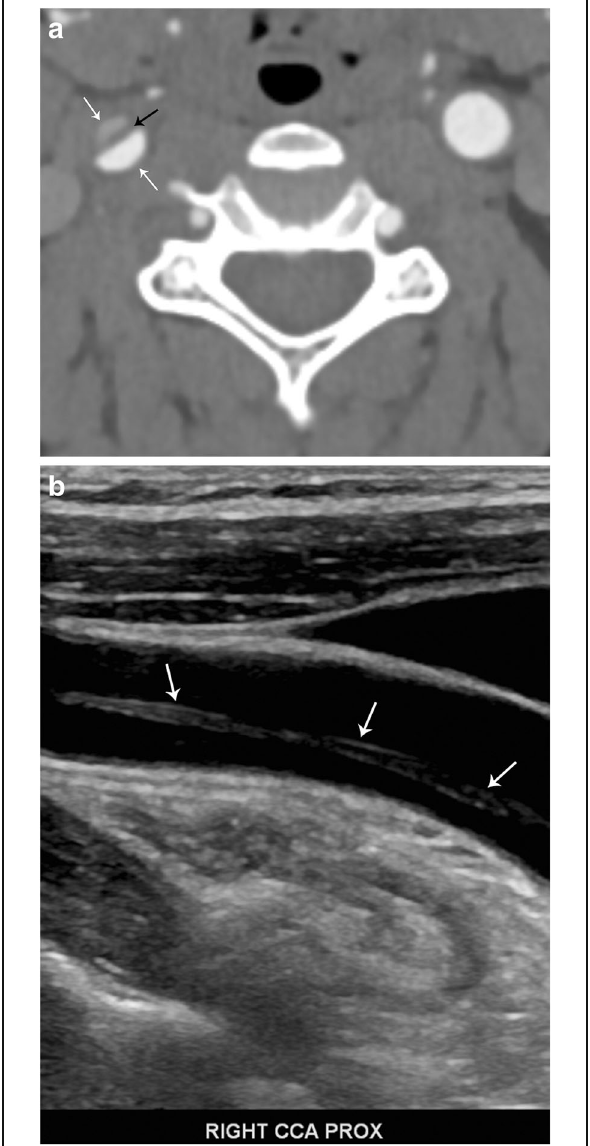
Fig. 12 Carotid arterial dissection. a Axial contrast-enhanced CT image demonstrates an intimal flap (black arrow) and "double lumen" sign (white arrows) in the right common carotid artery. b Sagittal grayscale ultrasound image confirms the diagnosis, demonstrating the intimal flap